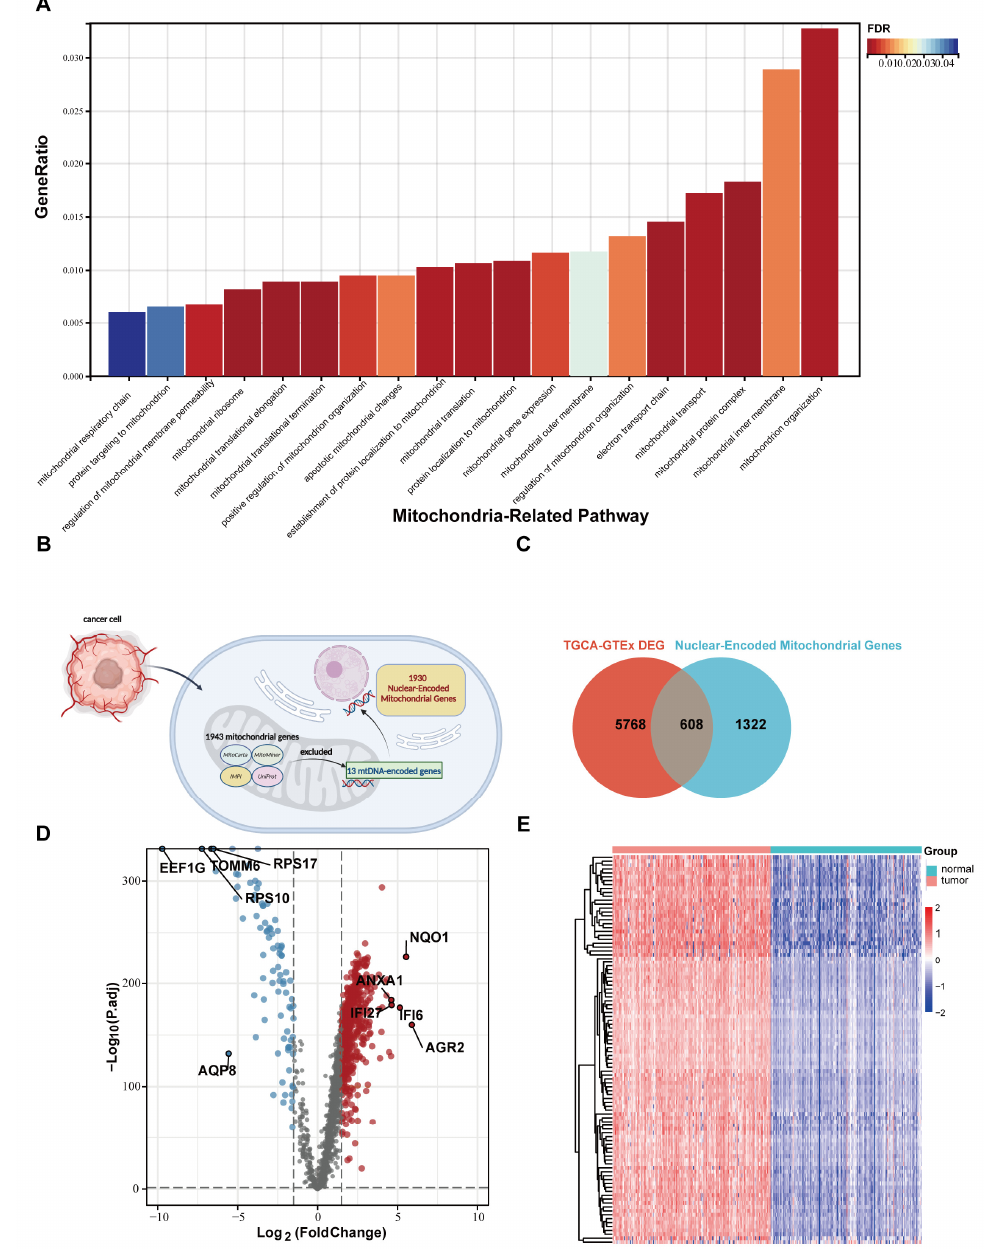
Figure 2. The analysis of mitochondrial dysfunction and nuclear mitochondria-related genes in PC. ( A ) Important mitochondria-related biological processes in the enrichment pathway of pancreatic cancer compared with the normal tissue. ( B ) The list of nuclear mitochondria-related genes determined by four datasets. ( C ) The Venn diagram indicates the interaction of nuclear mitochondria-related differential genes (nmDEGs) and pancreatic-cancer-related DEGs (PC − Normal DEGs). ( D ) The volcano plot displays the quantity of nuclear mitochondria-related DEGs between PC tissue and normal pancreatic tissue. ( E ) The heapmap shows the distribution of expression of nuclear mitochondria-related differential genes (nmDEGs).